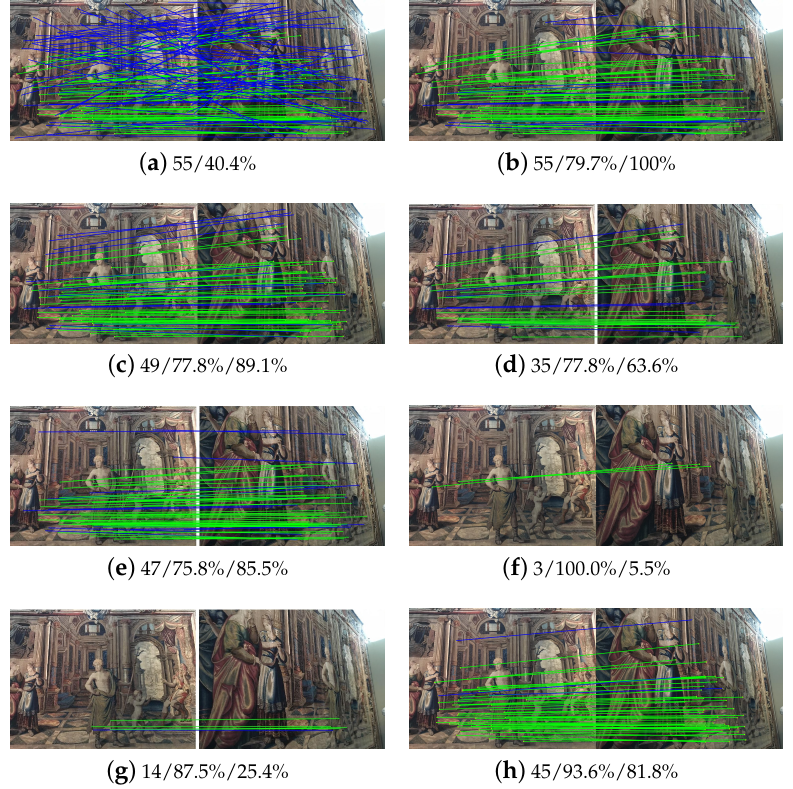
Figure 16. Matching results of image pair 8 in the rigid dataset: ( a ) initial matches; ( b )